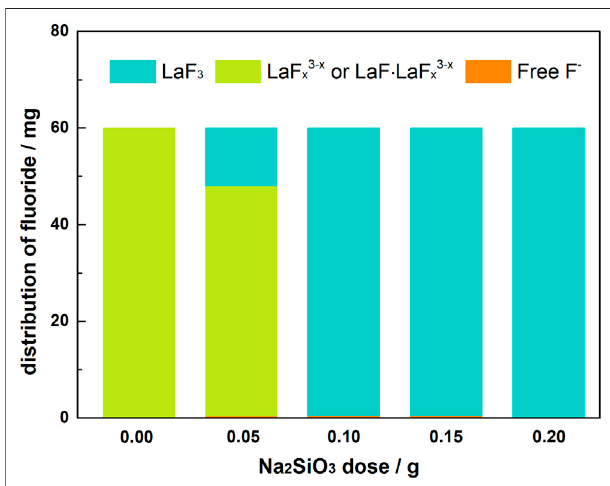
FIGURE 11 | Distribution of fl uorine element in aqueous solutions (La/F molar ratio = 1:3.00) after 1 h reaction in the presence of different doses of Na 2 SiO 3